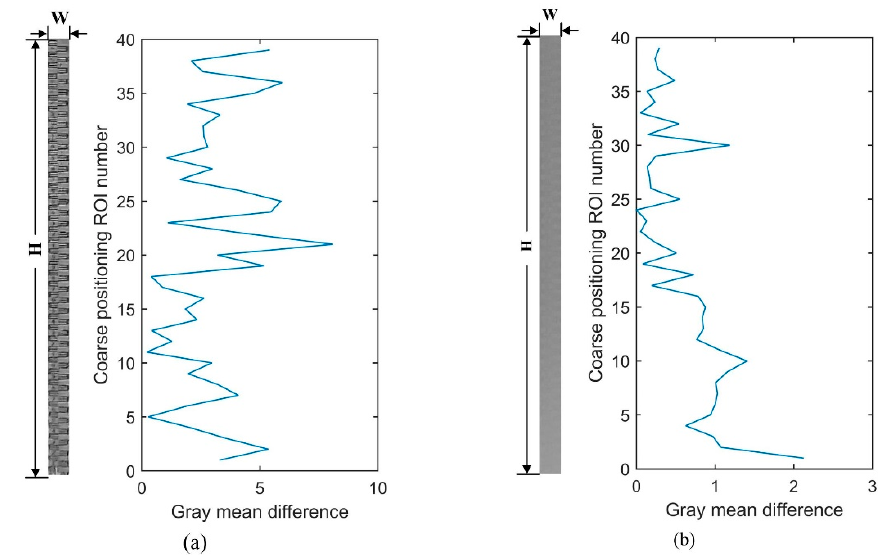
Figure 8. Gray mean difference of coarse positioning in unfavorable conditions: ( a ) out range; ( b ) poor visibility.